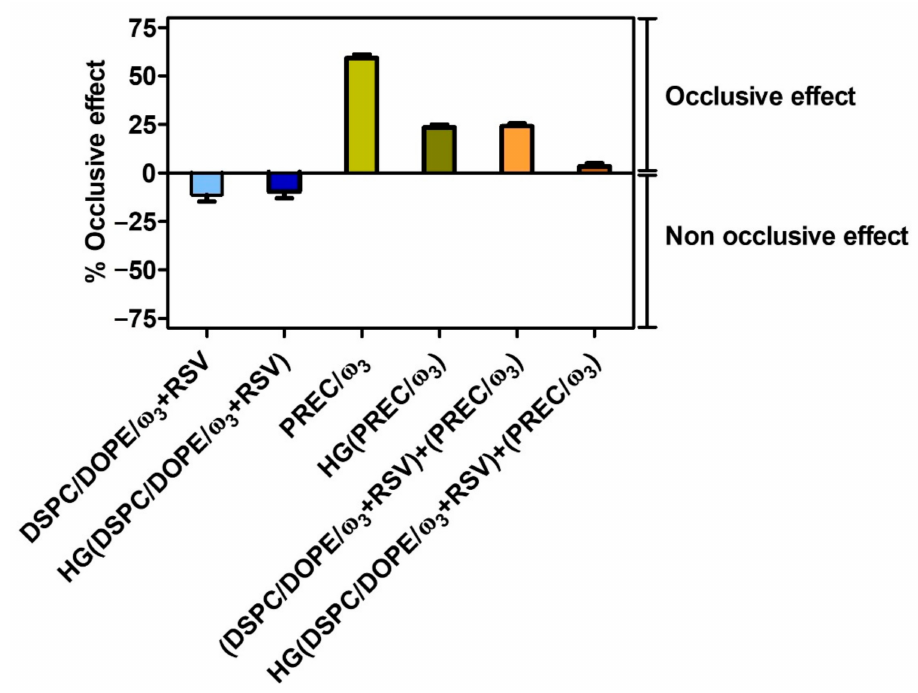
Figure 6. Occlusive effects (%) of free lipid nanosystems and of those included in the hydrogel (HG). The occlusive effects were calculated according to Equation (8). The data represent the means ±